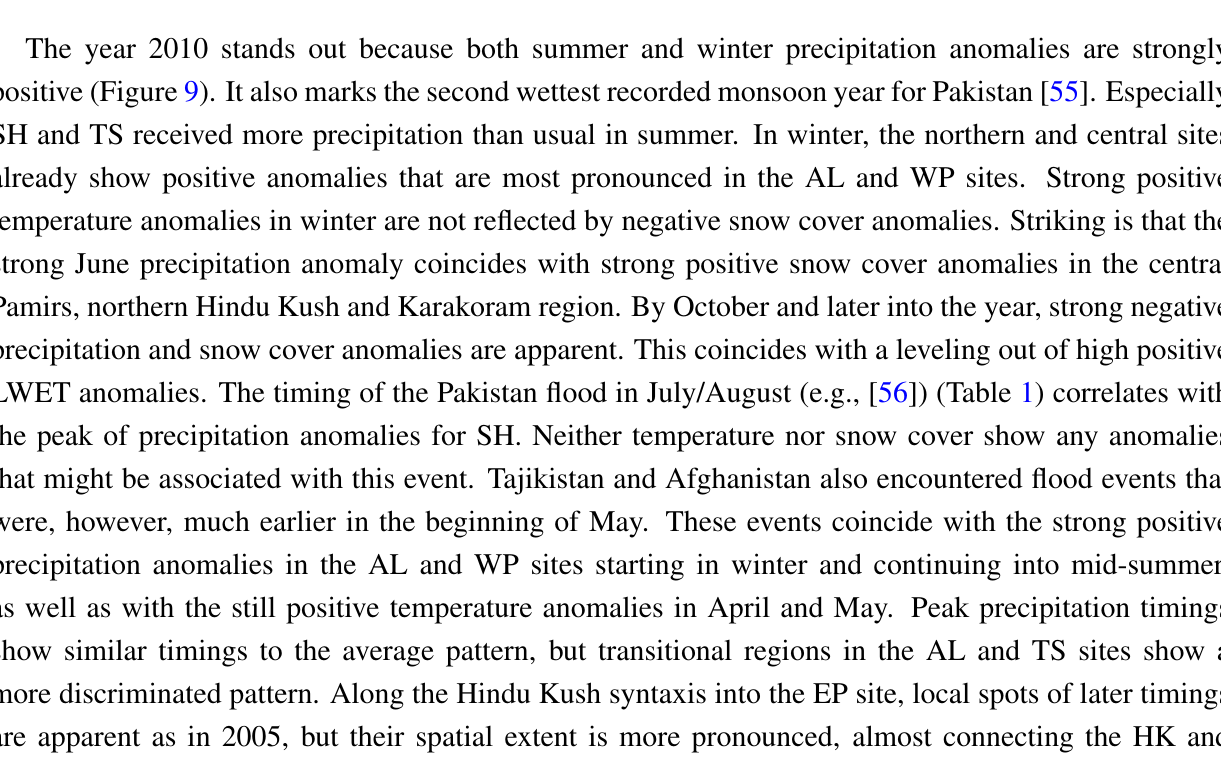
Figure 8. 2008 HANTS precipitation pattern for ( a ) winter and ( b ) summer. Gradually-evolving temperature anomalies ( c – e ) with a concentration of high temperatures at high altitude in the WP, EP and KK sites at the